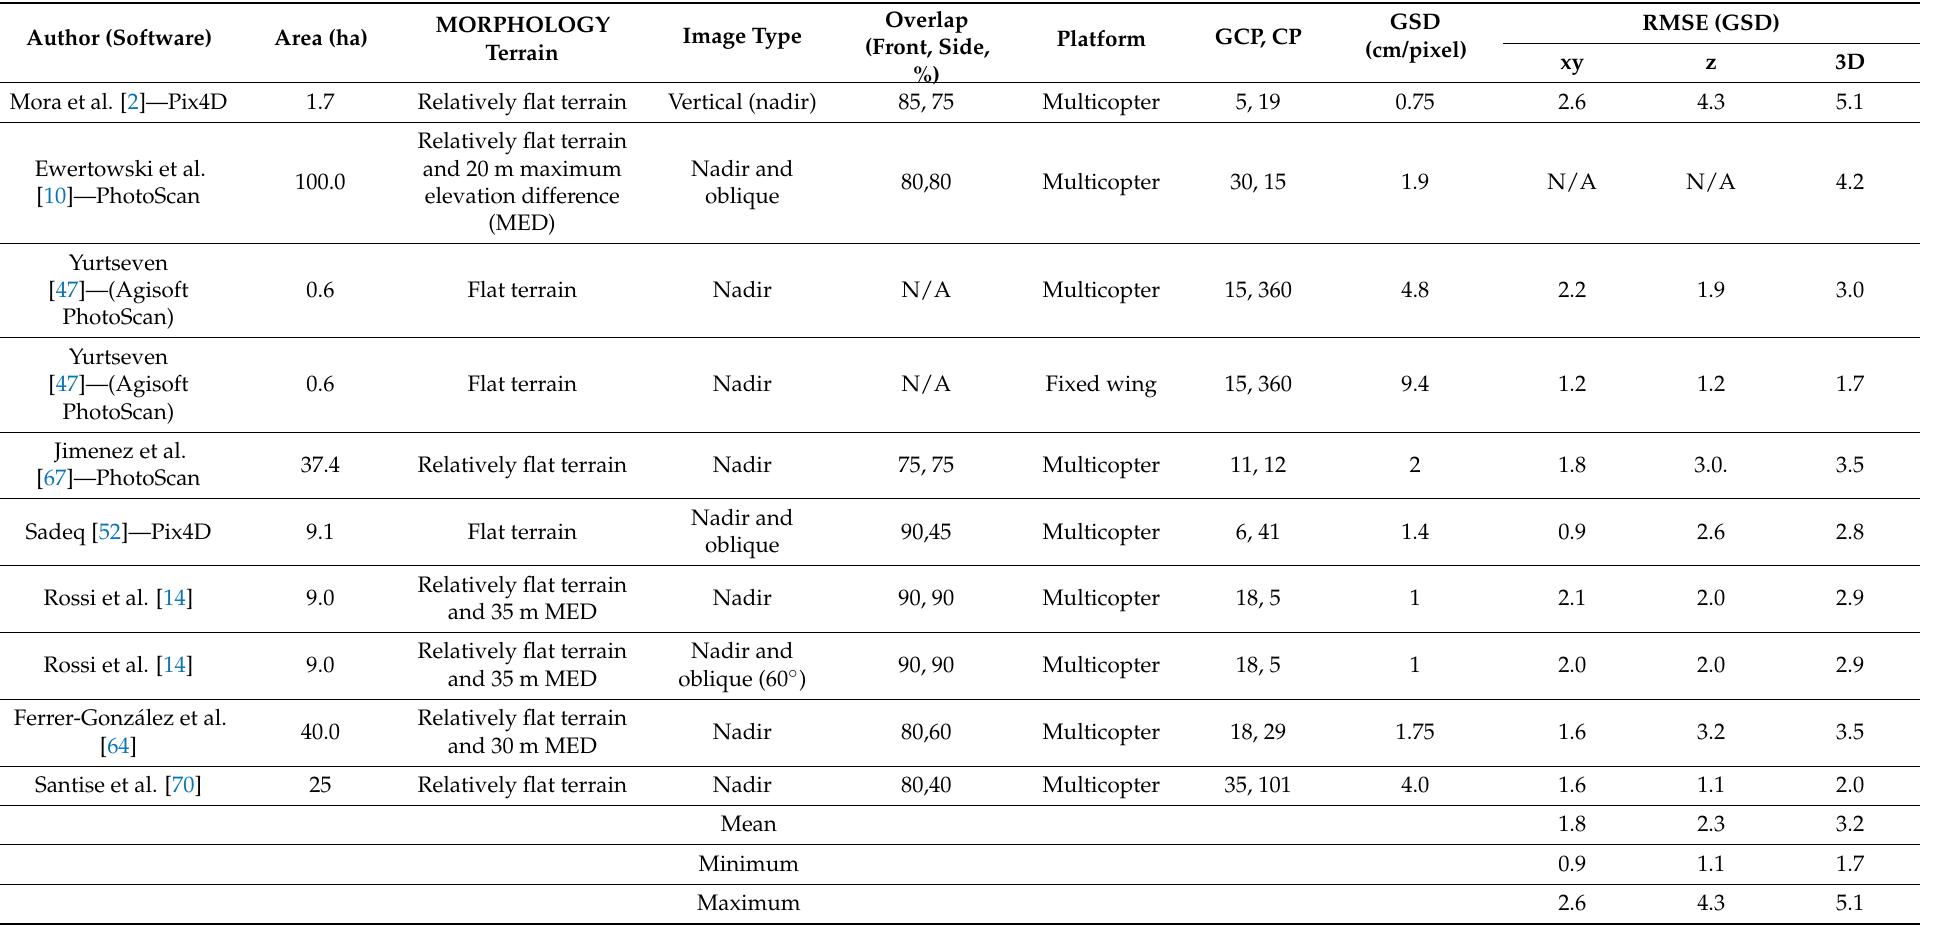
Table 6. The RMSE reported in different UAV photogrammetry studies for flat